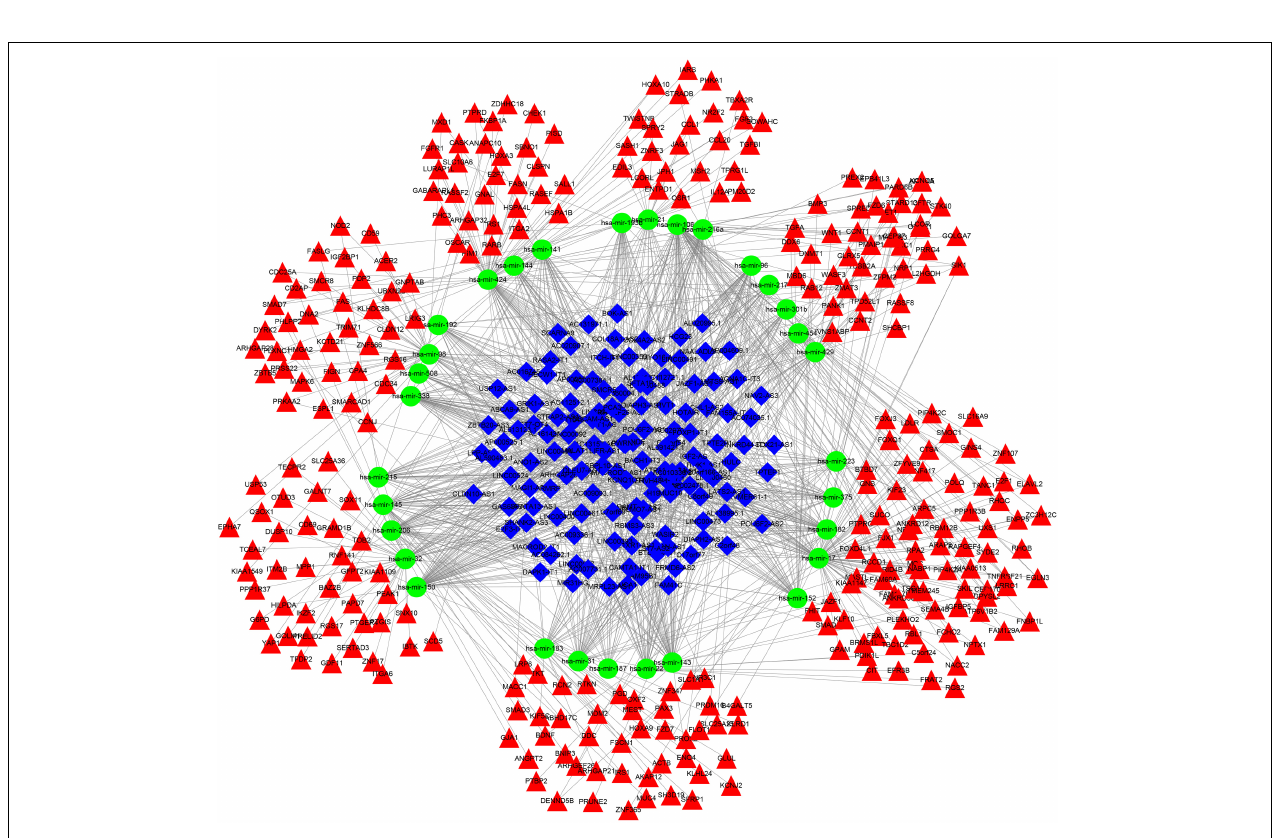
FIGURE 4 | A ceRNA network construction for acute lymphoblastic leukemia. Blue rhombus represents lncRNAs; green circle represents miRNAs and red triangle represents mRNAs.